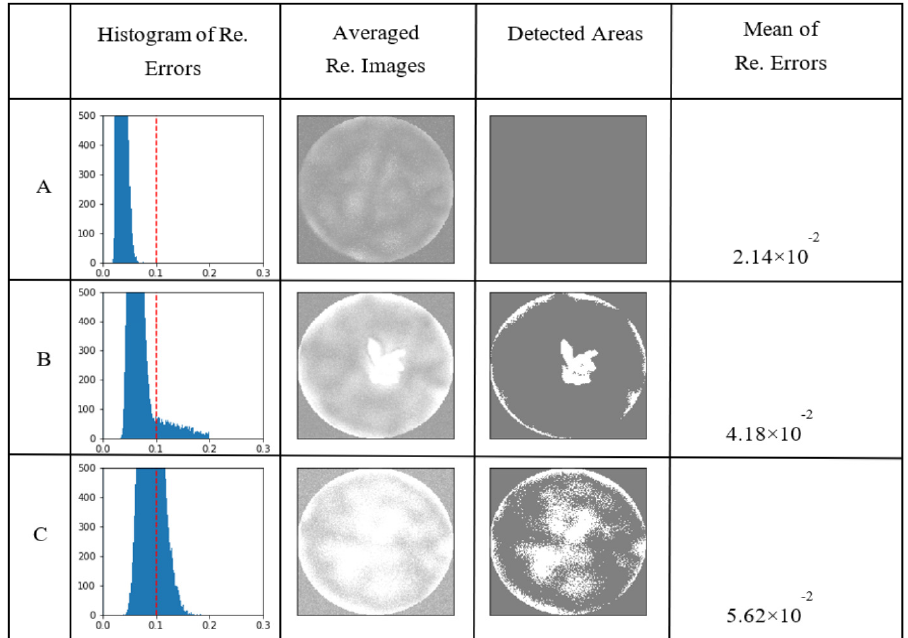
Figure 9. Detection of irregular areas using auto-encoder. A, B, and C corresponds to specimen (a), (b), and (c), respectively.